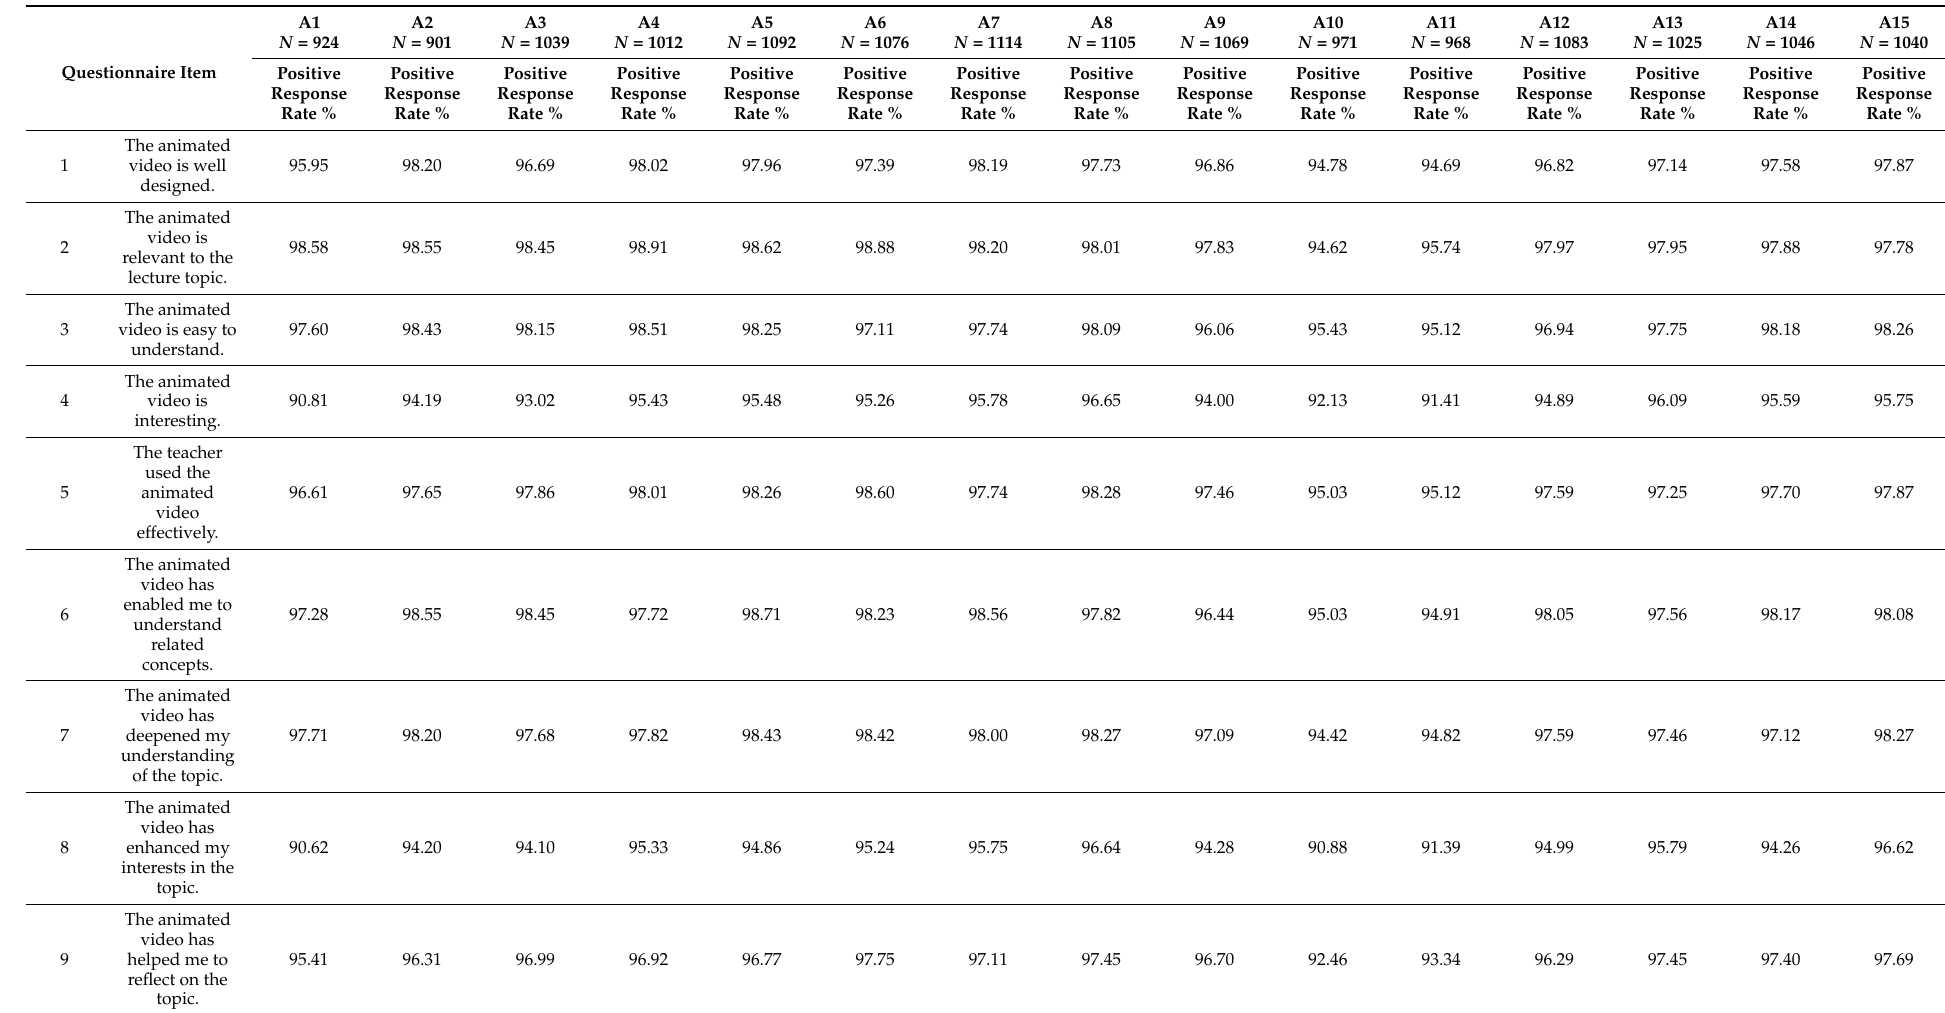
Table 5. Positive Responses Rates of Post-Lecture Video Evaluation for the 15 Animated Videos on